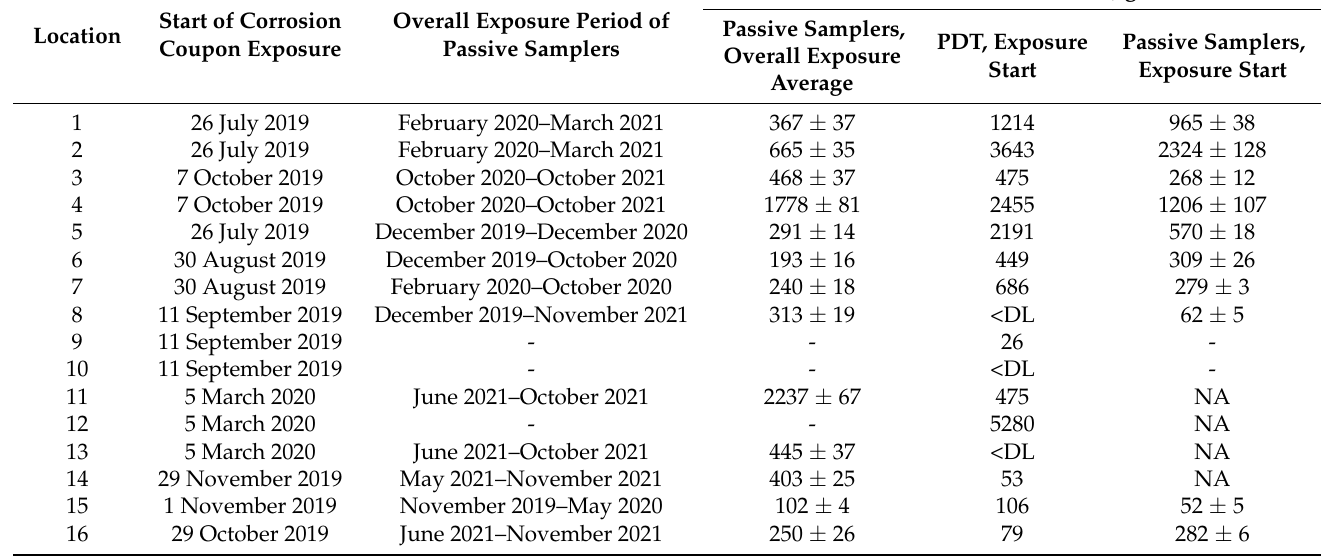
Table 1. Acetic acid